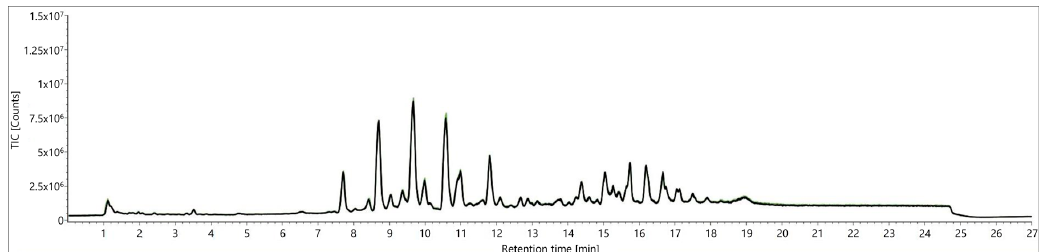
Figure 7. Comparison of TICs from a QC sample from a “green” Folch approach [27] for signal stability over five days: first five injections (green) versus the last five (injections 240–260, black).